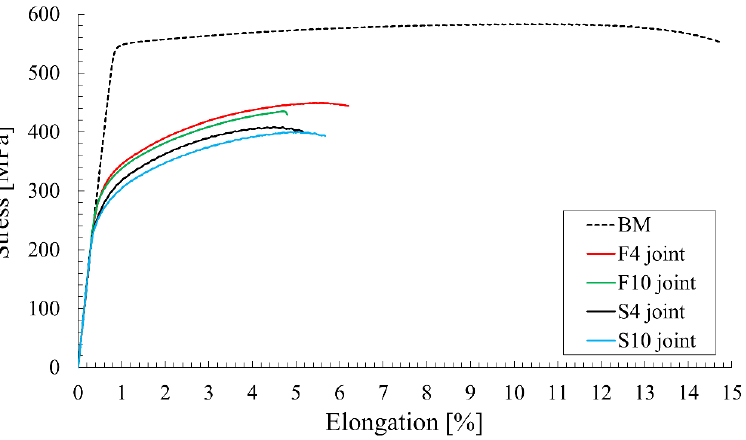
Figure 5. Comparison of tensile curves for the base material and joints produced with edged parameters.